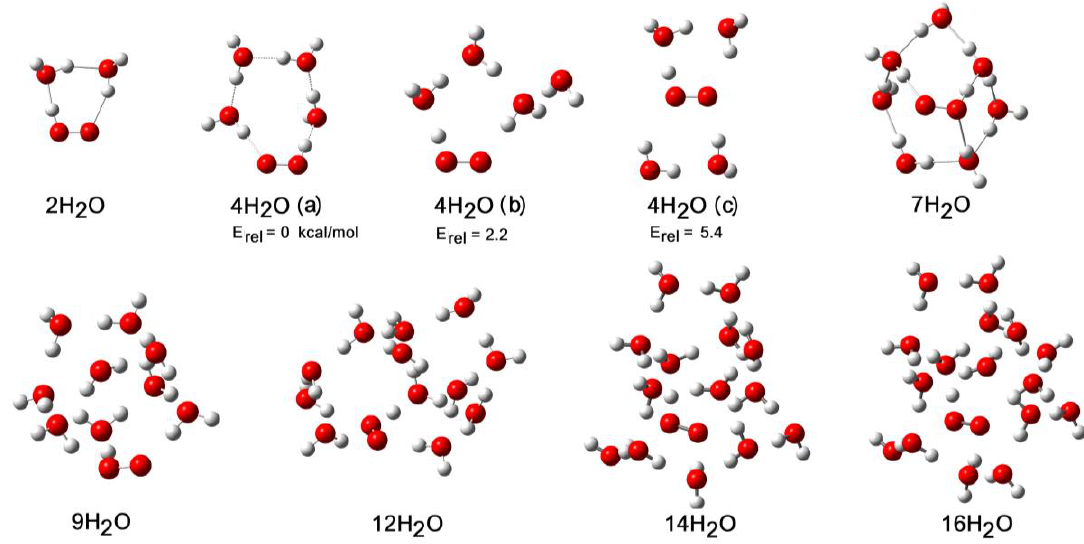
Figure 7. Optimum Structures of Selected HOO • Radical/Water Clusters ( 5H . n H 2 O).